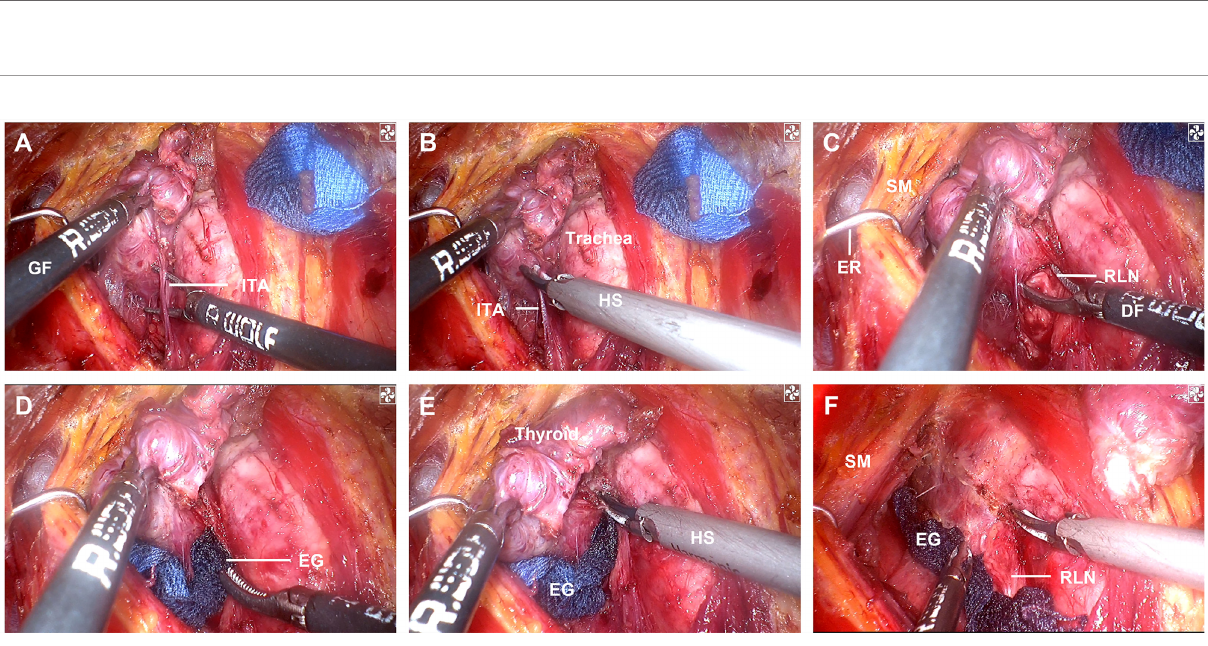
FIGURE 4 | INTP strategy was applied in trans breast endoscopic thyroidectomy. (A) Expose the inferior pole of thyroid lobe. (B) Expose one segment of RLN. (C) Establish the “ neural tunnel ” . (D) Endoscopic gauze was stuffed. (E) UltraCision implementation upon the gauze. (F) Completing RLN separation pathway. GF, grasp forceps; ITA, inferior thyroid artery; HS, harmonic scalpel; SM, strap muscles; DF, dissection forceps; RLN, recurrent laryngeal nerve; EG, endoscopic gauze; INTP, intraoperative nerve tunnel